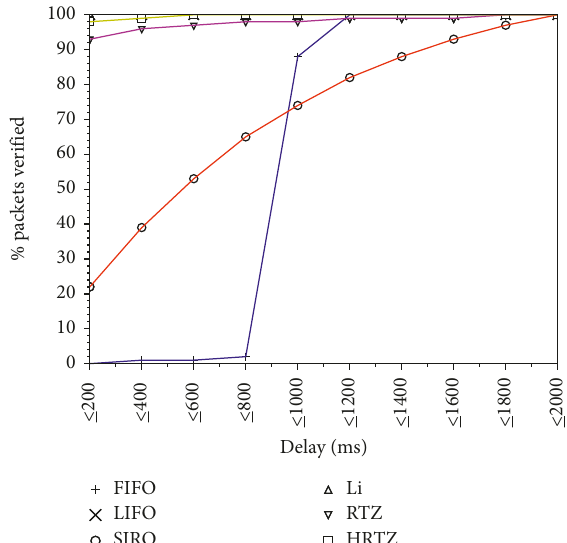
Figure 10: The cumulative percentage of verified messages versus delay of verified messages.